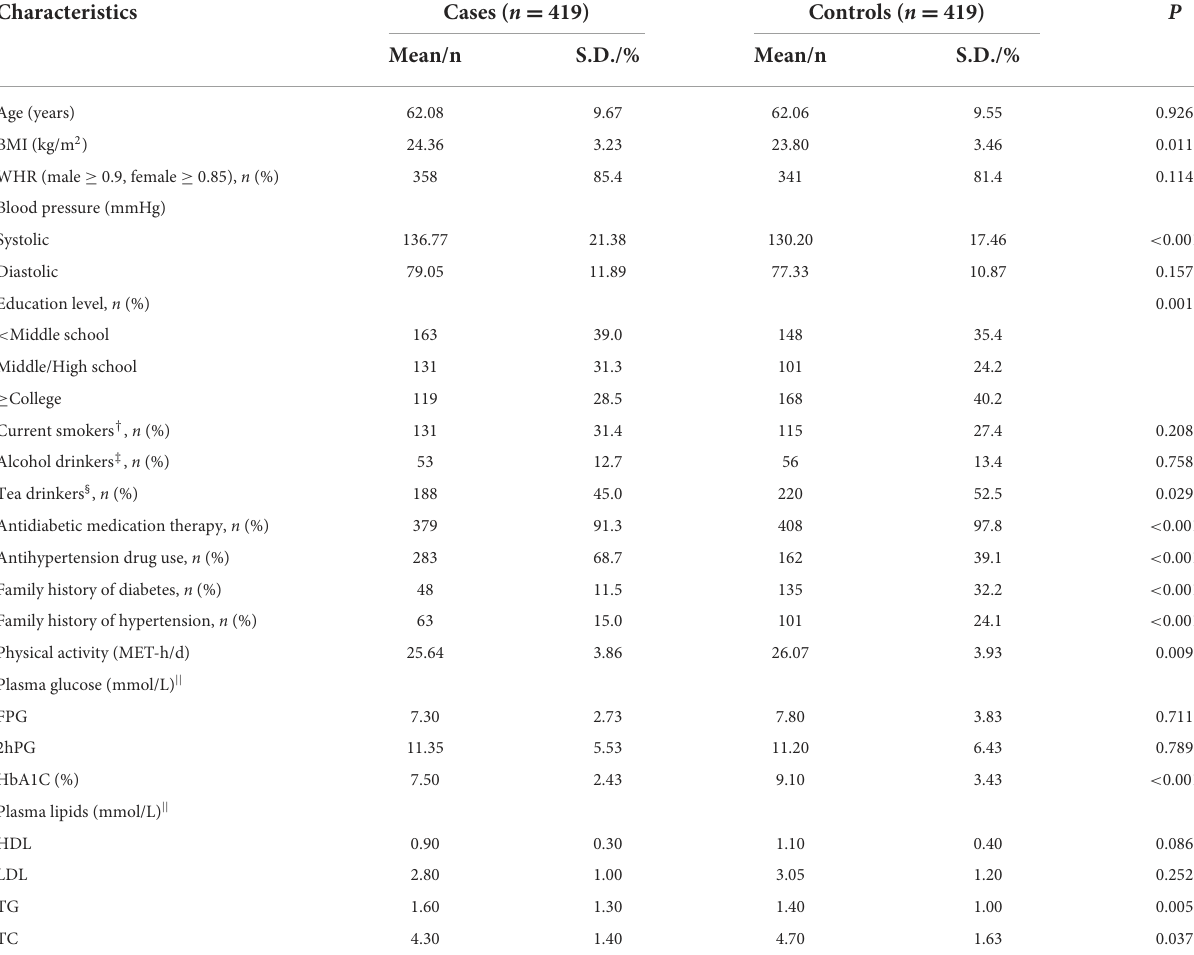
TABLE 2 Characteristics included cases and